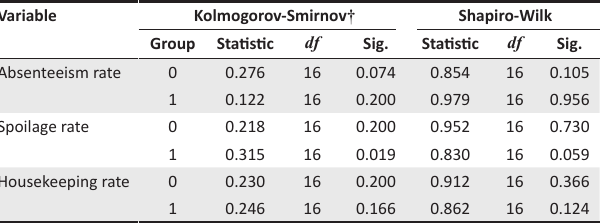
TABLE 2: Normality tests for absenteeism, spoilage and housekeeping rates. Variable Kolmogorov-Smirnov † Shapiro-Wilk Group